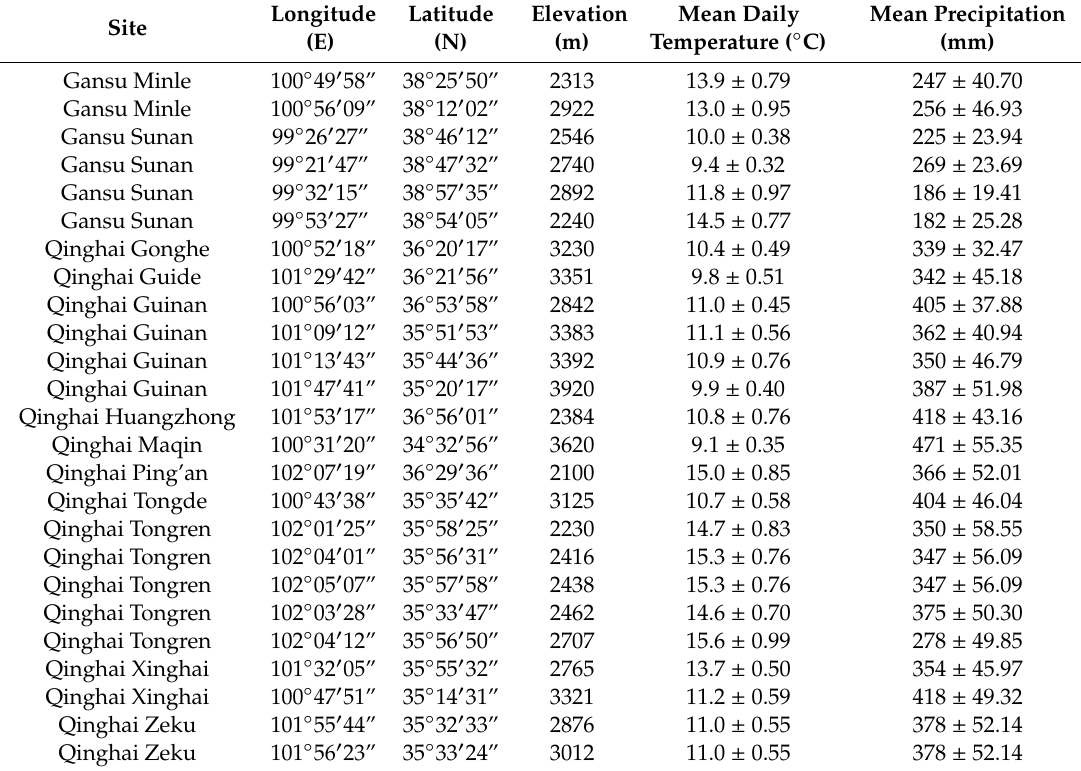
Table 1. Co-ordinates of longitude and latitude, elevation and the interpolated growing season mean daily temperature and mean precipitation (average ± standard error (SE)).